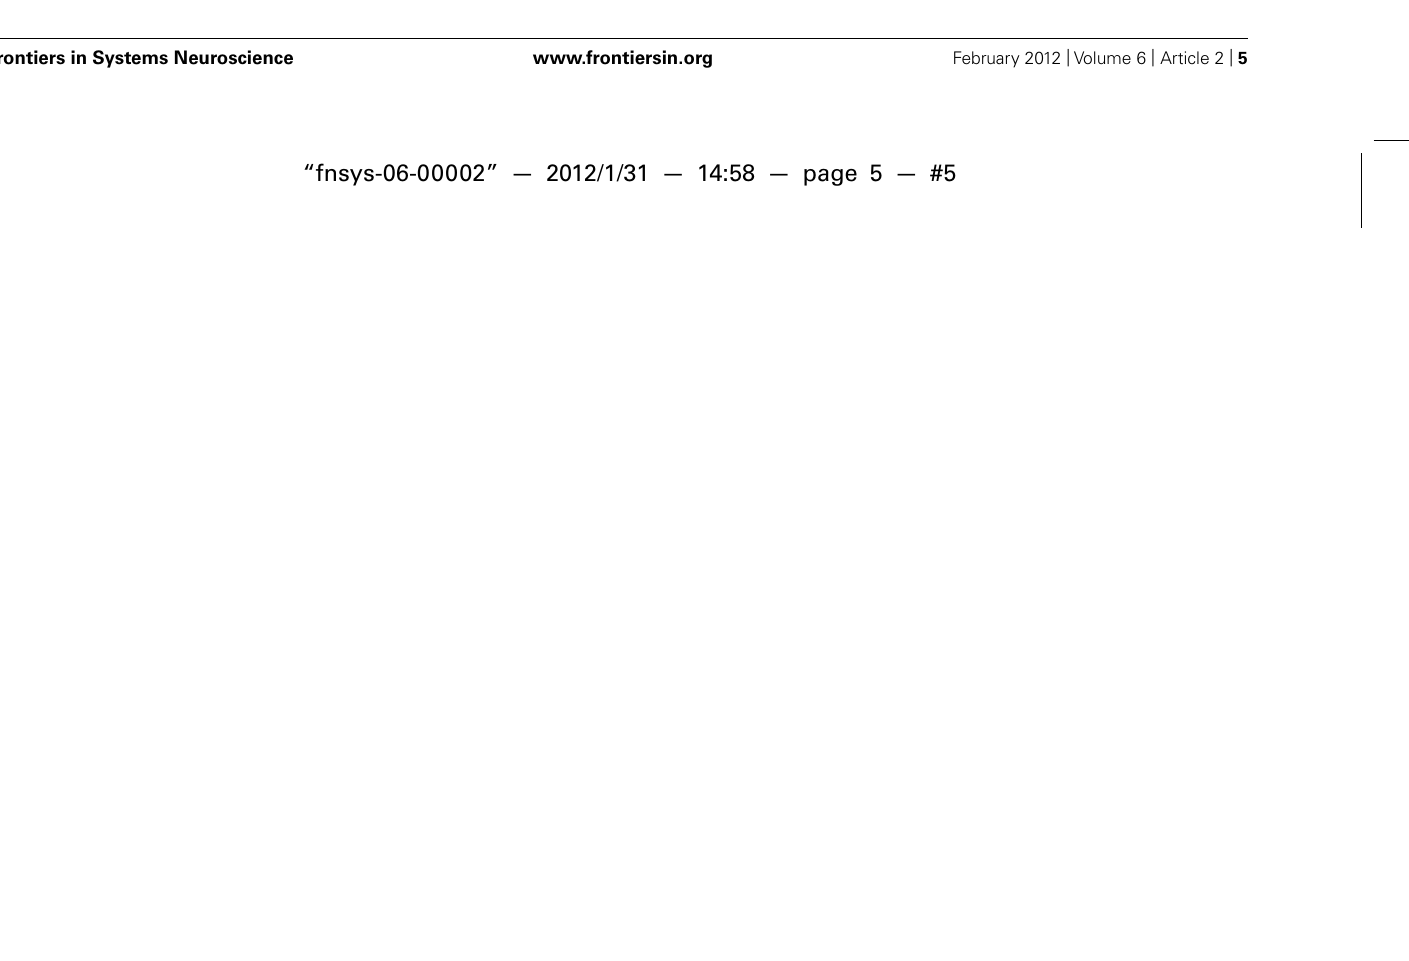
FIGURE 1 | (A) Hearing thresholds were measured at frequencies from 0.25 to 16.00 kHz. Results were averaged over both ears, and shown by means of boxplots (showing inter-quartile ranges). Stimuli were presented at all octave frequencies from 0.25 to 8.00 kHz at two different intensity levels that differed by 20 dB.The light gray bars indicate the approximate presentation levels. In the analysis, the sound-evoked activation levels were interpolated to a uniform intensity level of 40 dB HL, indicated by the dark gray line.